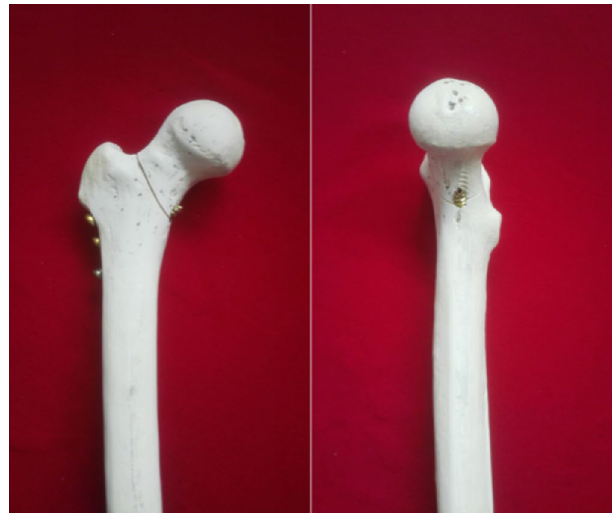
Figure 1. Model of medial femoral neck support